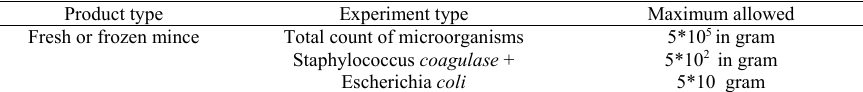
Table1. Maximum allowed number of colonies per pack of minced meat